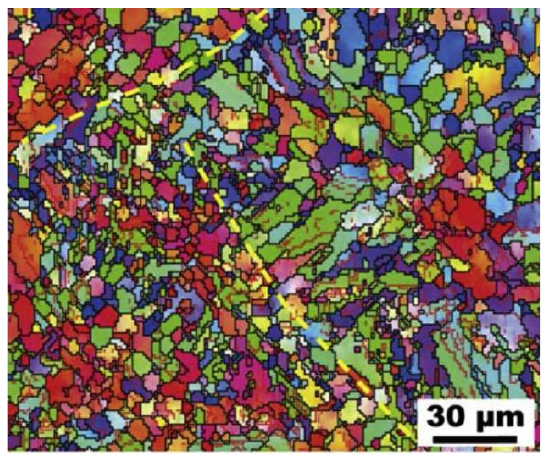
Figure 14. Electron backscatter diffraction image of LPBF [55] .